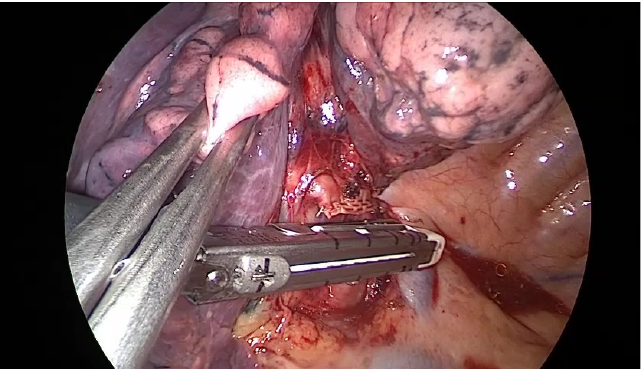
Figure 8. Uniportal VATS right upper lobectomy for centrolobar metastasis—stapling the right up- per lobe venous drainage. VATS = Video-Assisted Thoracic Surgery. lobe venous drainage. VATS = Video-Assisted Thoracic